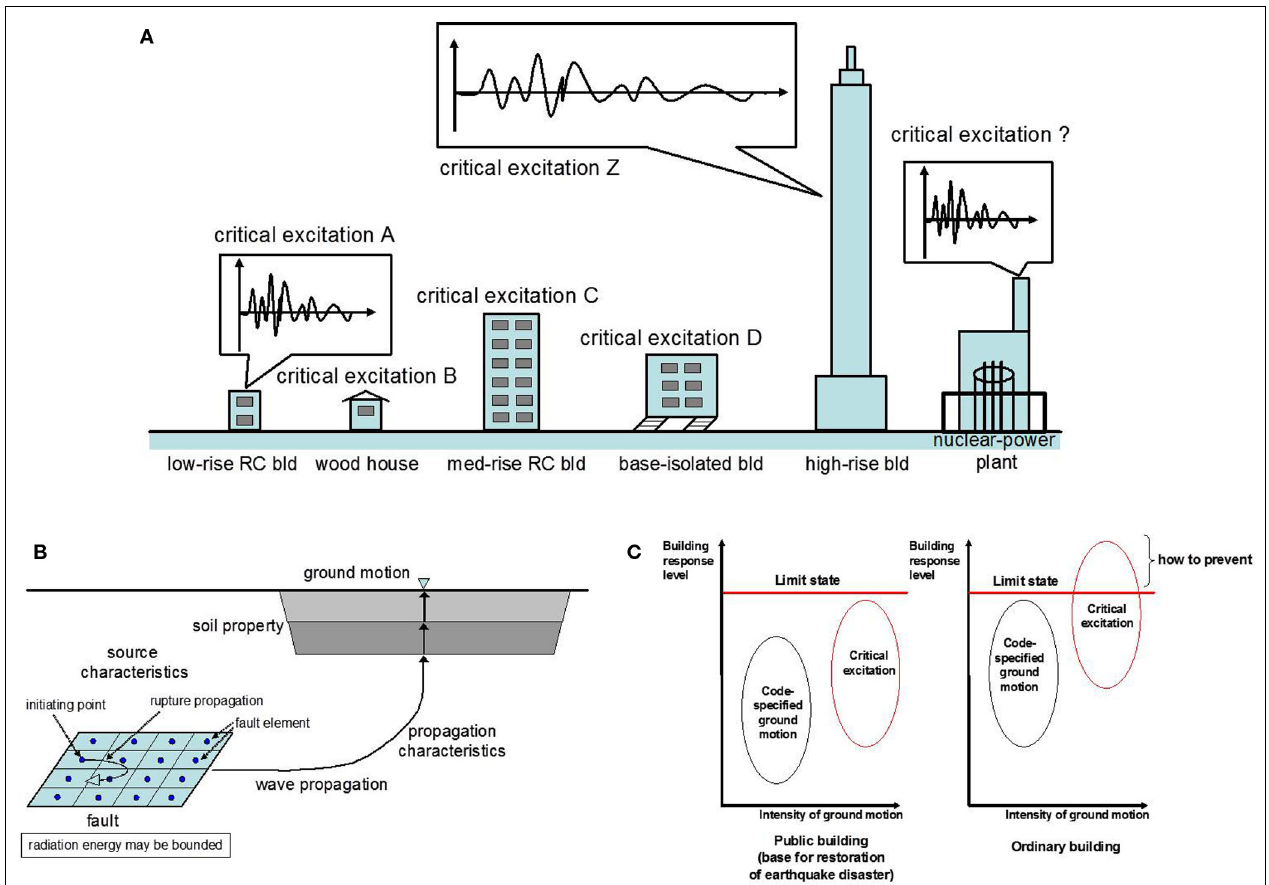
FIGURE 1 | (A) Critical excitation for each building and facility (Takewaki, 2008a), (B) earthquake ground motion depending on fault rupture mechanism, wave propagation and surface ground amplification, etc. (Takewaki, 2006/2013), (C) relation of critical excitation with code-specified ground motion in public and ordinary buildings (Takewaki,